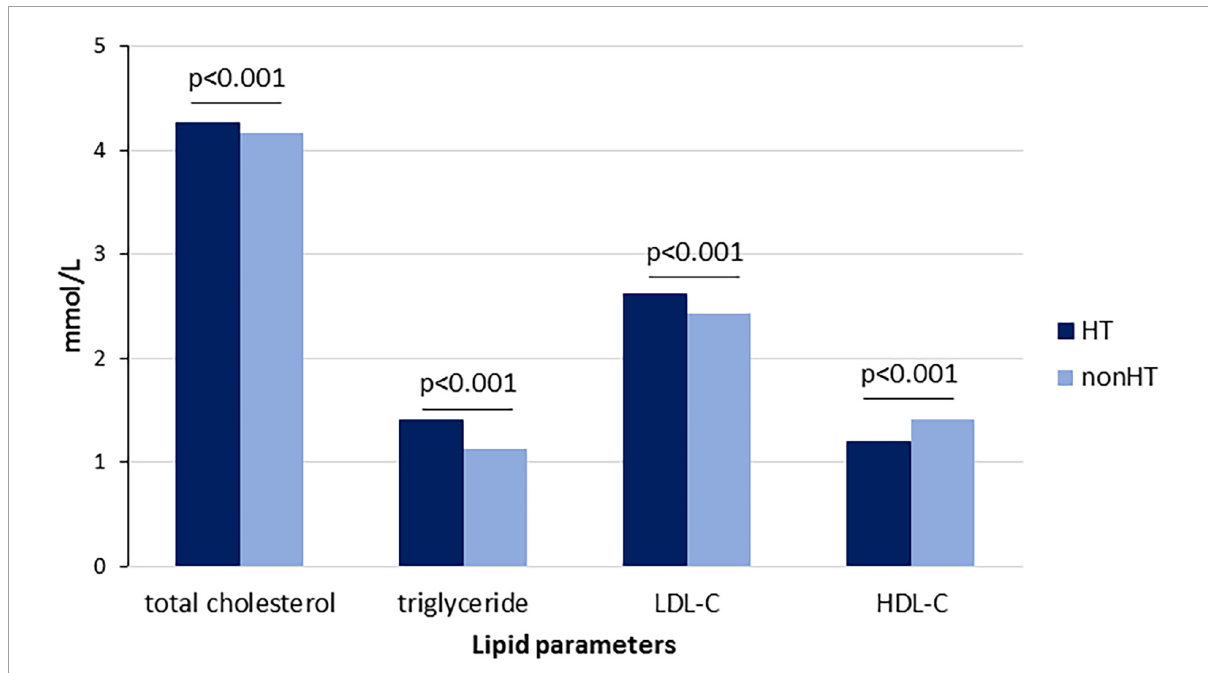
FIGURE4 Serum lipid parameters in children with and without hypertension in the whole patient